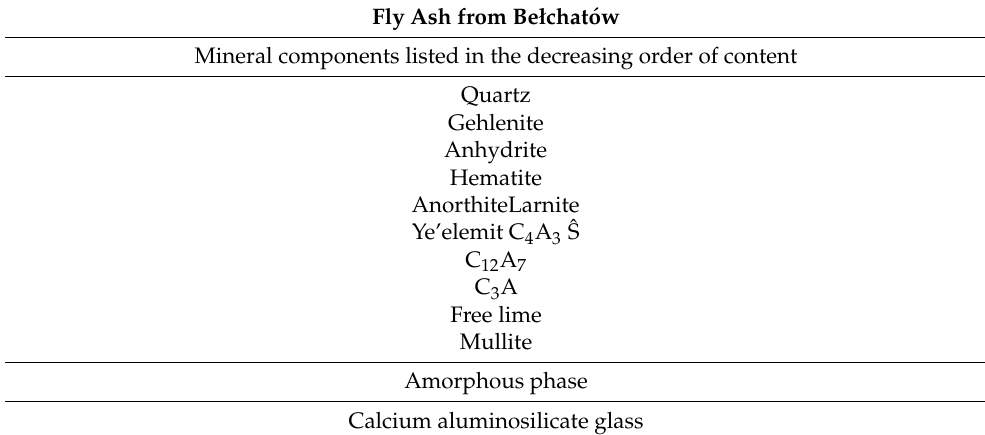
Table 3. Phase composition of the Belchat ó w lignite fly ash.